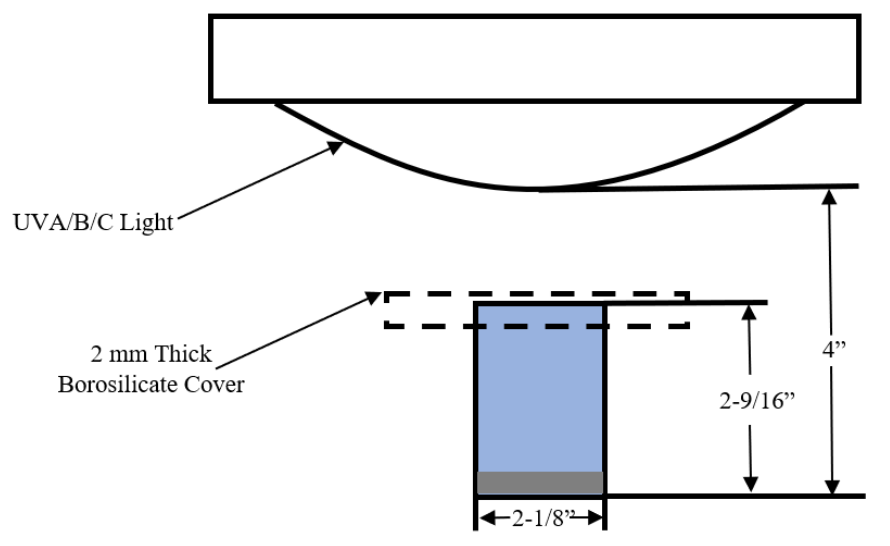
Figure 16. Photocatalytic testing setup.